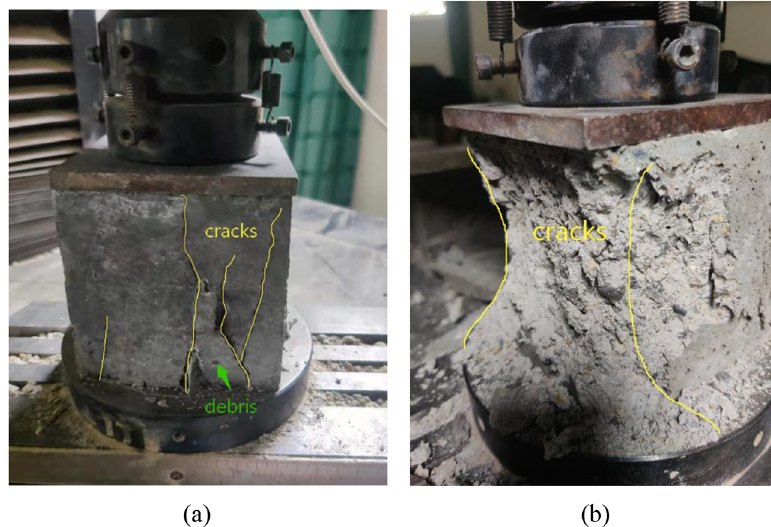
Figure 6: Benchmark group. ( a ) During fracturing and ( b ) complete fracturing.